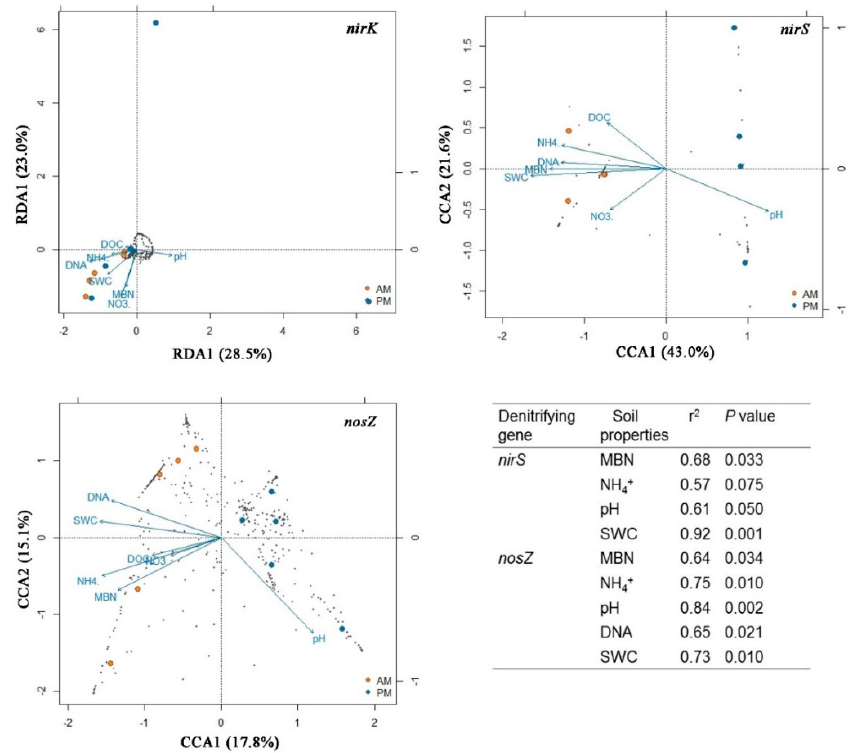
Figure 2. Redundancy analysis (RDA) and canonical correspondence analysis (CCA) illustrating the specific structure of the denitrifying bacterial communities and the associated factors in the Acacia mangium (AM) and Pinus massoniana (PM) plantations. Soil properties that are significantly correlated to the denitrifying bacterial community structure are shown in the table at the lower right corner.